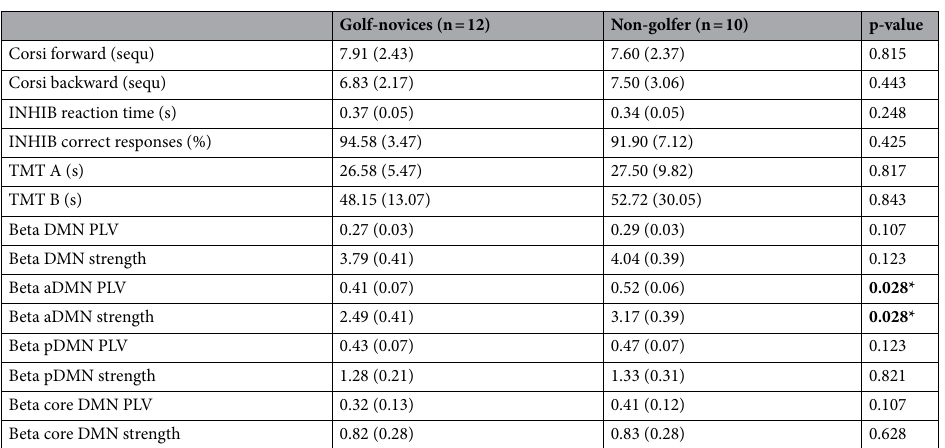
Table 2. Group differences were examined with the Mann–Whitney-U Test at a significance level of p < 0.05. Bonferroni-corrected p-values are reported. Variables are presented as means with standard deviation. INHIB response inhibition, TMT trail making test, DMN default mode network, PLV phase locking value, aDMN anterior default mode network, pDMN posterior default mode network, core DMN caudal anterior